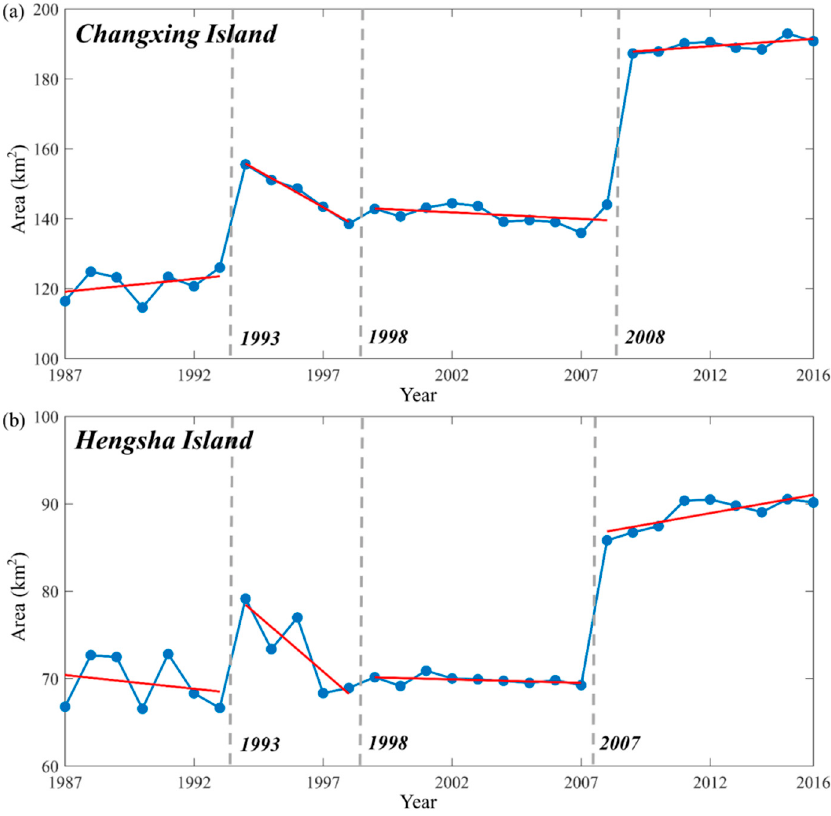
Figure 9. Annual variations in the land areas of ( a ) Changxing Island and ( b ) Hengsha Island during 1987–2016. The red line represents the linear regression line for each sub-period.